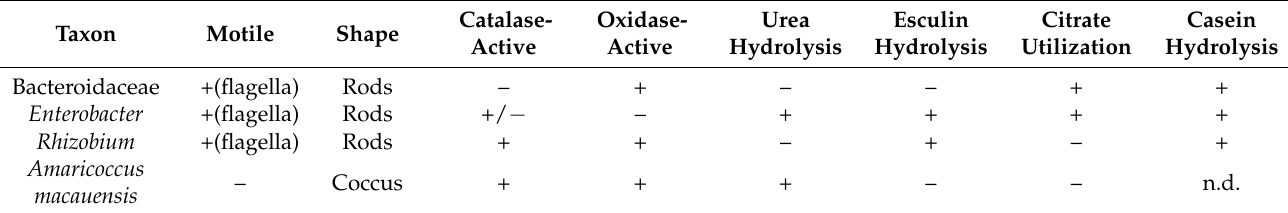
Table 3. Selected Gram-negative bacterial taxa not affected by